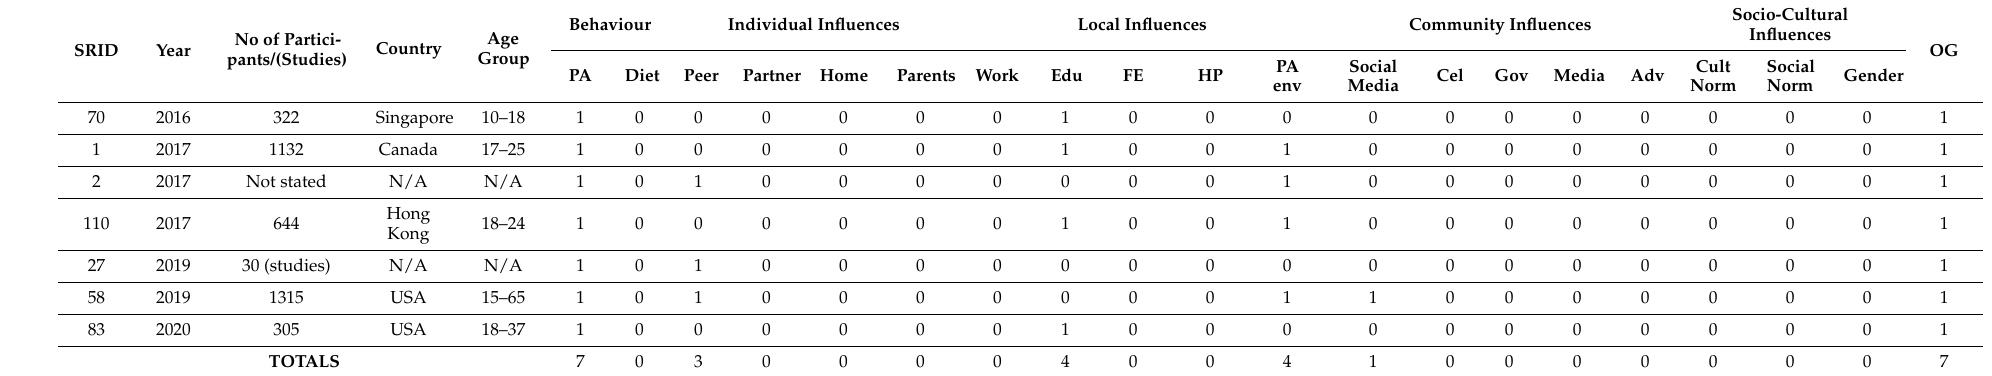
Table 2. Characteristics of scoping review studies—online game studies